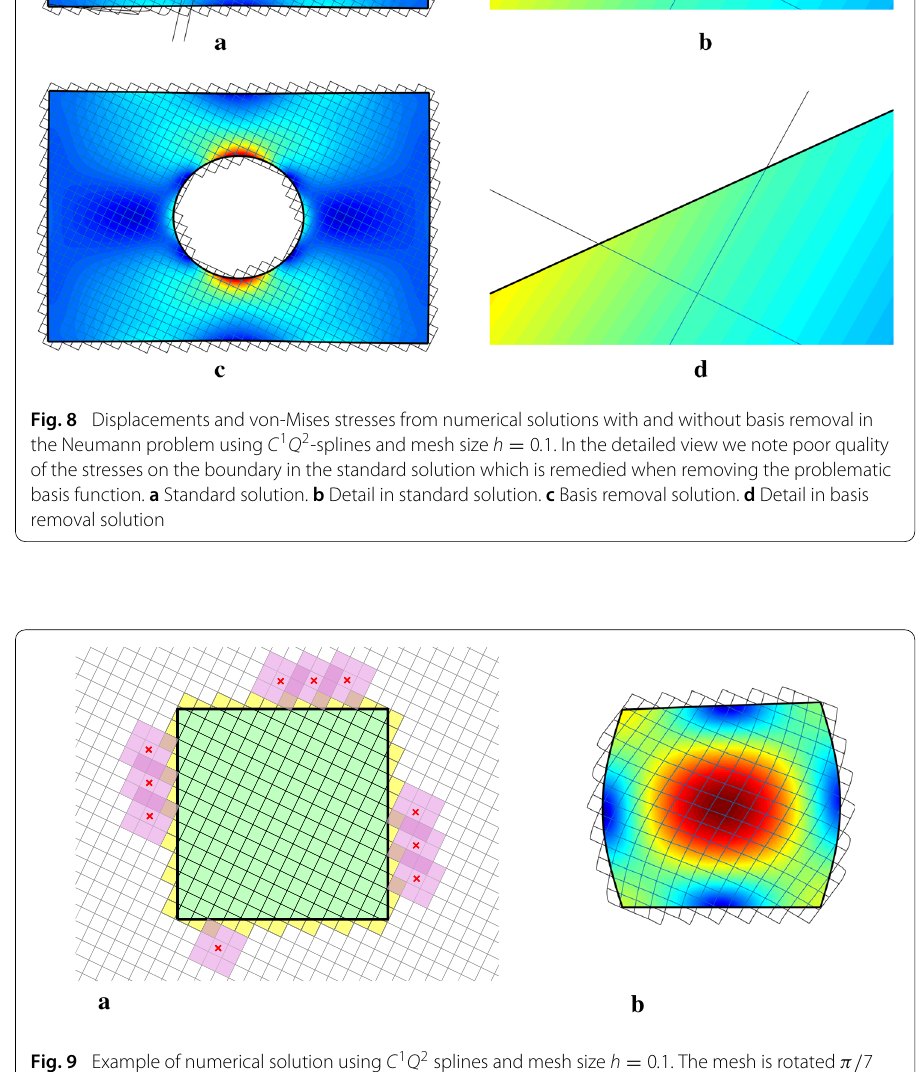
corresponding to these convergence studies is presented in Fig. 10b. It can be noted that while basis removal greatly reduce the size of the condition numbers, basis removal alone does not yield an optimal scaling of O ( h − 2